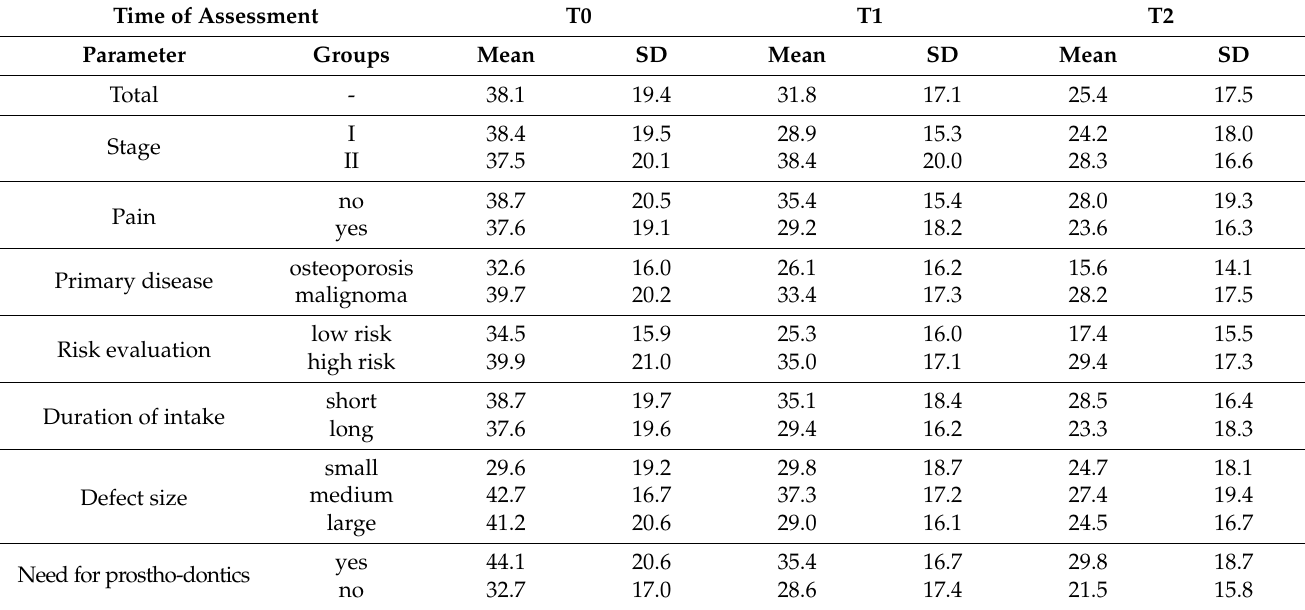
Table 6. Mean VAS2-6 values for all parameters and assessment times (T0/T1/T2). SD: standard